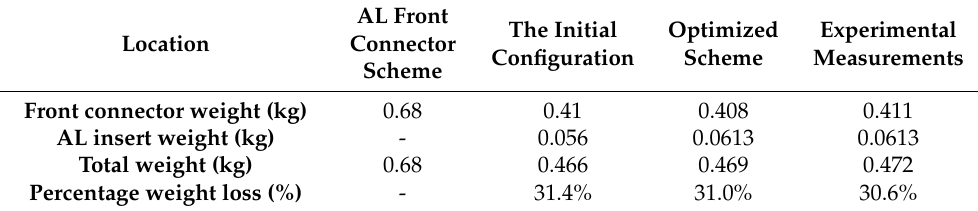
Table 3. Front connector weight of different